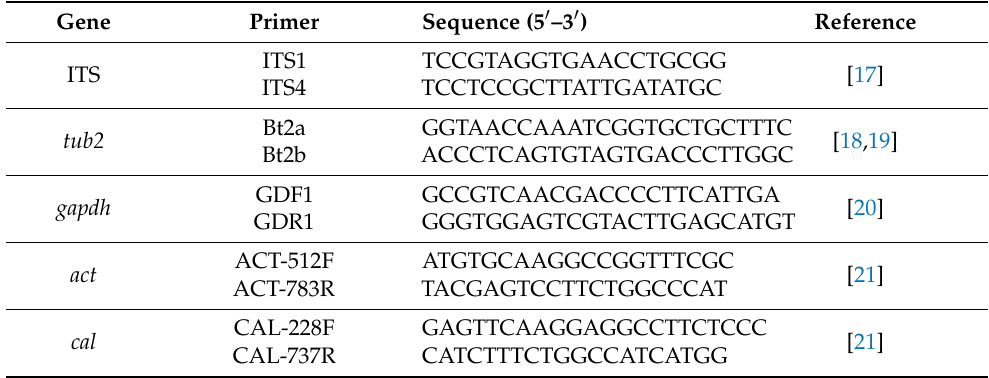
Table 1. Primers used for PCR amplifications and DNA